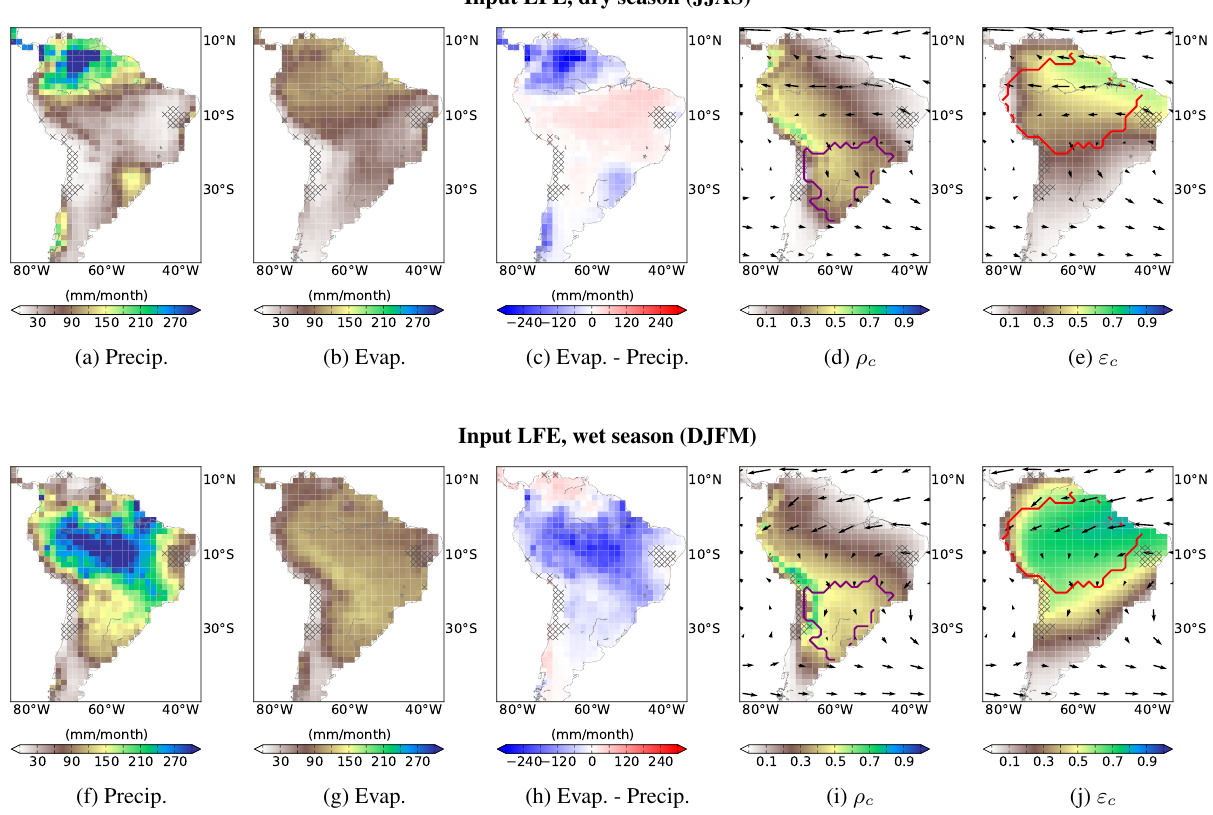
Fig. 2: Same as Fig. 1 for the period 1990–1995 as calculated from LandFluxEval and an average of four observation-based Figure 2. Same as Fig. 1 for the period 1990–1995 as calculated from LandFlux-EVAL and an average of four observation-based precipitation products (input LFE; see Table precipitation products (input LFE, see Table 1).